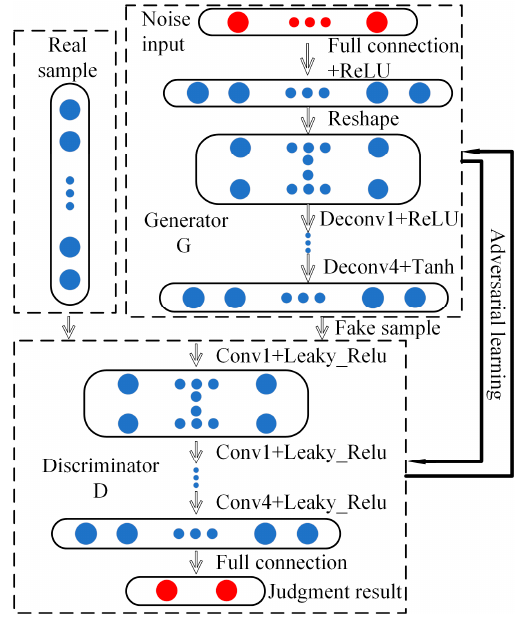
Figure 1. The structure of DCGAN.